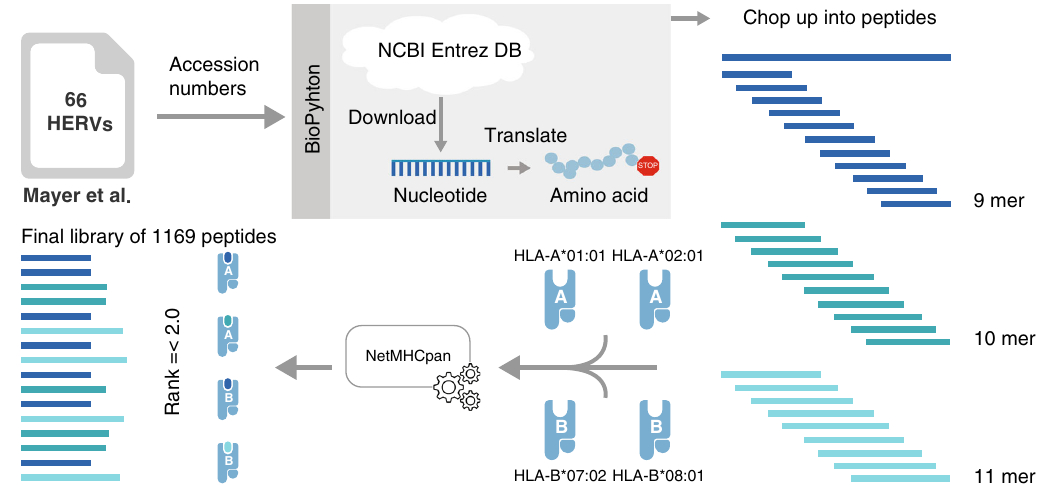
Fig. 1 Schematic of HERV-derived peptides selected for T cell analysis. Accession numbers for known transcribed HERVs published by Mayer et al. were used to download the reported nucleotide sequences from the National Center for Biotechnology Information ’ s (NCBIs) Entrez database (DB). The sequences were translated into amino acids until a stop codon occurred. Thereafter, the sequences were chopped into 9-, 10-, and 11mer peptides. Binding of all extracted peptides to the four most common Caucasian HLA alleles (HLA-A*01:01, -A*02:01, -B*07:02, and -B*08:01) was predicted using NetMHCpan 2.8. The fi nal library consists of 1169 peptides from 49 of the 66 HERVs, all with a predicted binding percentile rank score of 2 or below to any of the four HLA